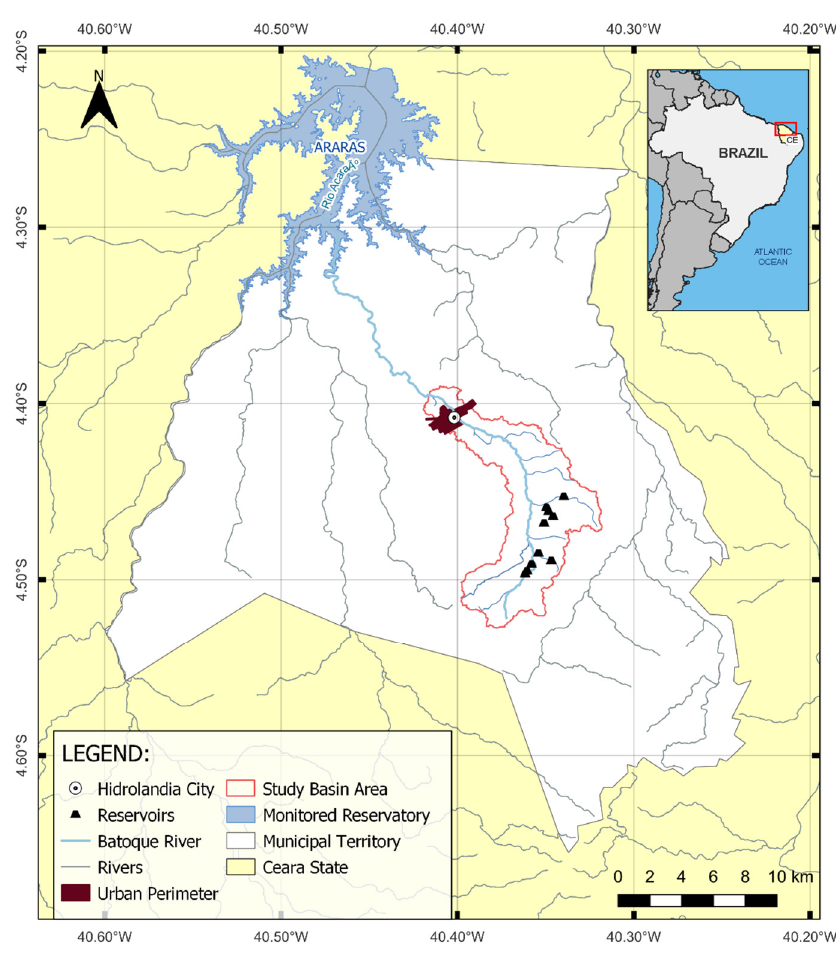
Figure 4. Batoque sub-basin, located in the semi-arid region of Ceara State in Brazil. The climate of the study area is described as tropical, hot, and semi-arid, with average annual temperature variations from 26 °C to 28 °C [31]. The rainy season, influenced by the Intertropical Convergence Zone (ITCZ) [31,32], is marked by seasonality and occurs between December and July, whose peak is concentrated between March and